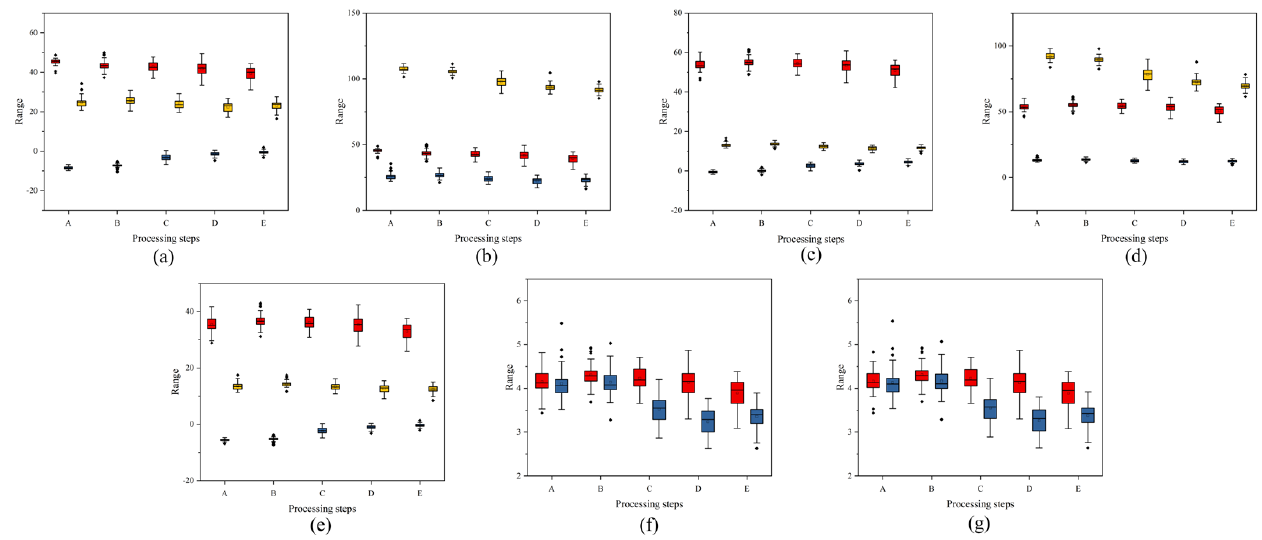
Figure 5. Trend of chromaticity and gloss during processing: ( a – e ) box plot of color difference value parameters under different testing standards of ( a ) L*a*b*; ( b ) L*C*h; ( c ) L99a99b99; ( d ) L99C99h99; ( e ) L (hunter) a (hunter) and b (hunter); ( f – g ) box plot of glossiness parameters under different test- ing standards of ( f ) Munsell C value and Munsell C chroma; and ( g ) Munsell D65 value and Munsell Table 3. Range of main colorimetric parameters during processing.